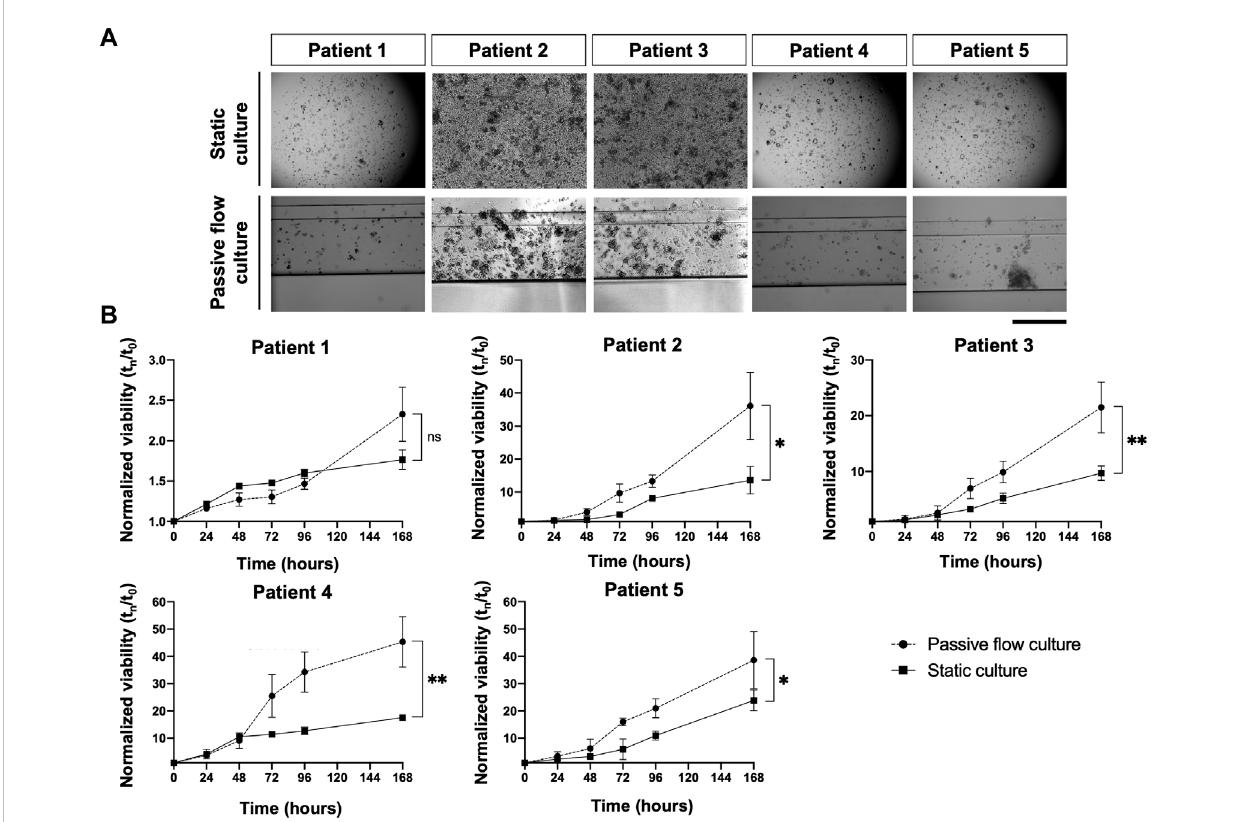
FIGURE 6 In the dynamic platform a higher growth rate is observed. (A) Representative bright- fi eld images of organoids in static and passive fl ow cultures are shown. Scalebar 500 μ m; (B) The growth curve of organoids derived from patients in static and passive fl ow conditions. Cell viability was measured